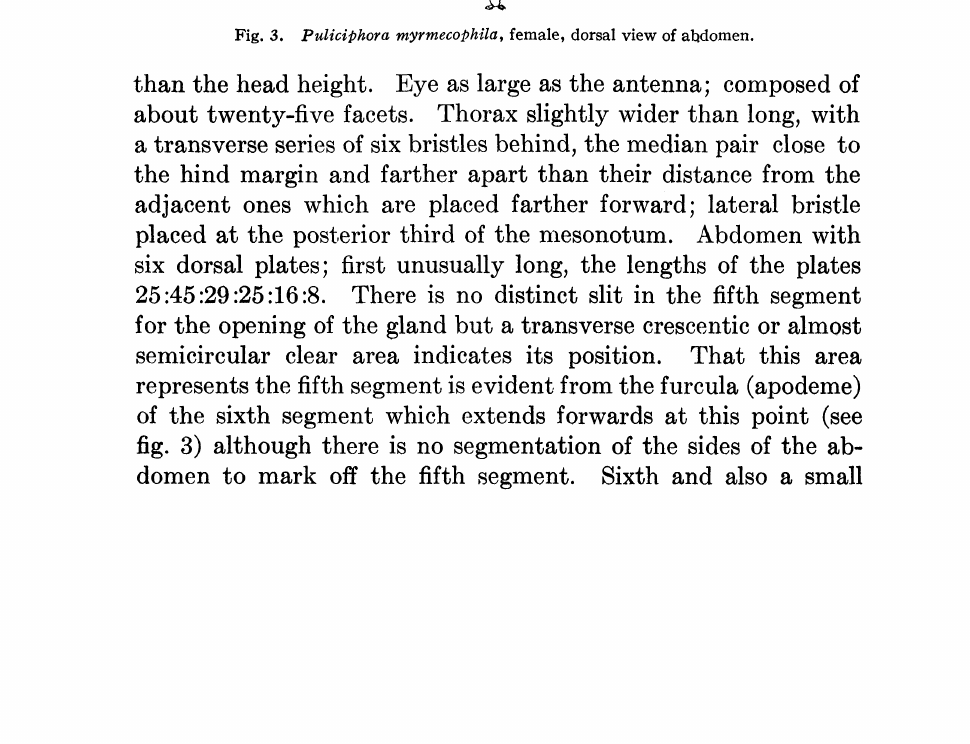
Fig. 3. Puliciphora myrmecophila, female, dorsal view of